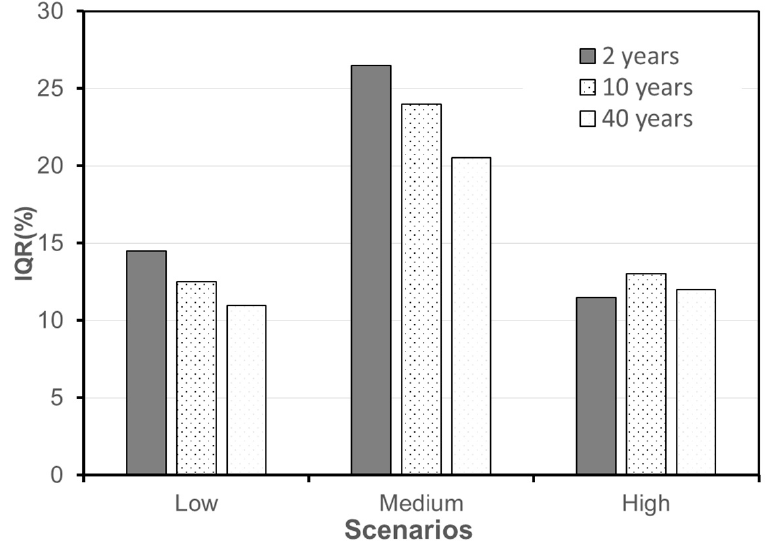
Figure 8. Variations in interquartile range of the TSS reduction efficiency of sub-catchments with various design storms.